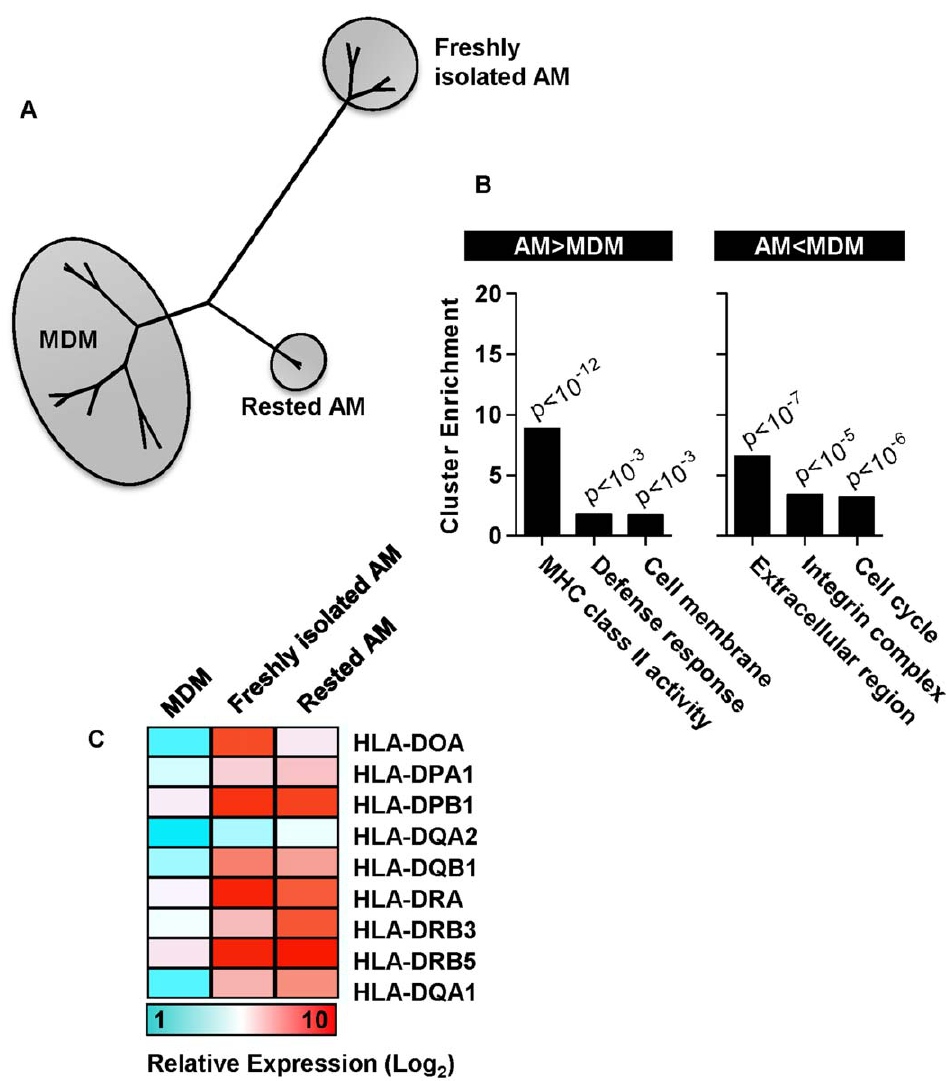
Figure 5. Genome-wide comparison of MDM with freshly isolated and rested AM. (A) Hierarchical clustering of whole genome expression profiles showed greatest difference between MDM and freshly isolated AM, and closer clustering of rested AM to MDM. (B) Significant gene expression differences between rested AM and MDM assessed by gene ontology functional cluster analysis, showed greatest enrichment for upregulated expression in AM of genes associated with MHC class II antigen presentation pathways. (C) Mean relative gene expression levels are presented in MDM and AM for genes included in this cluster.